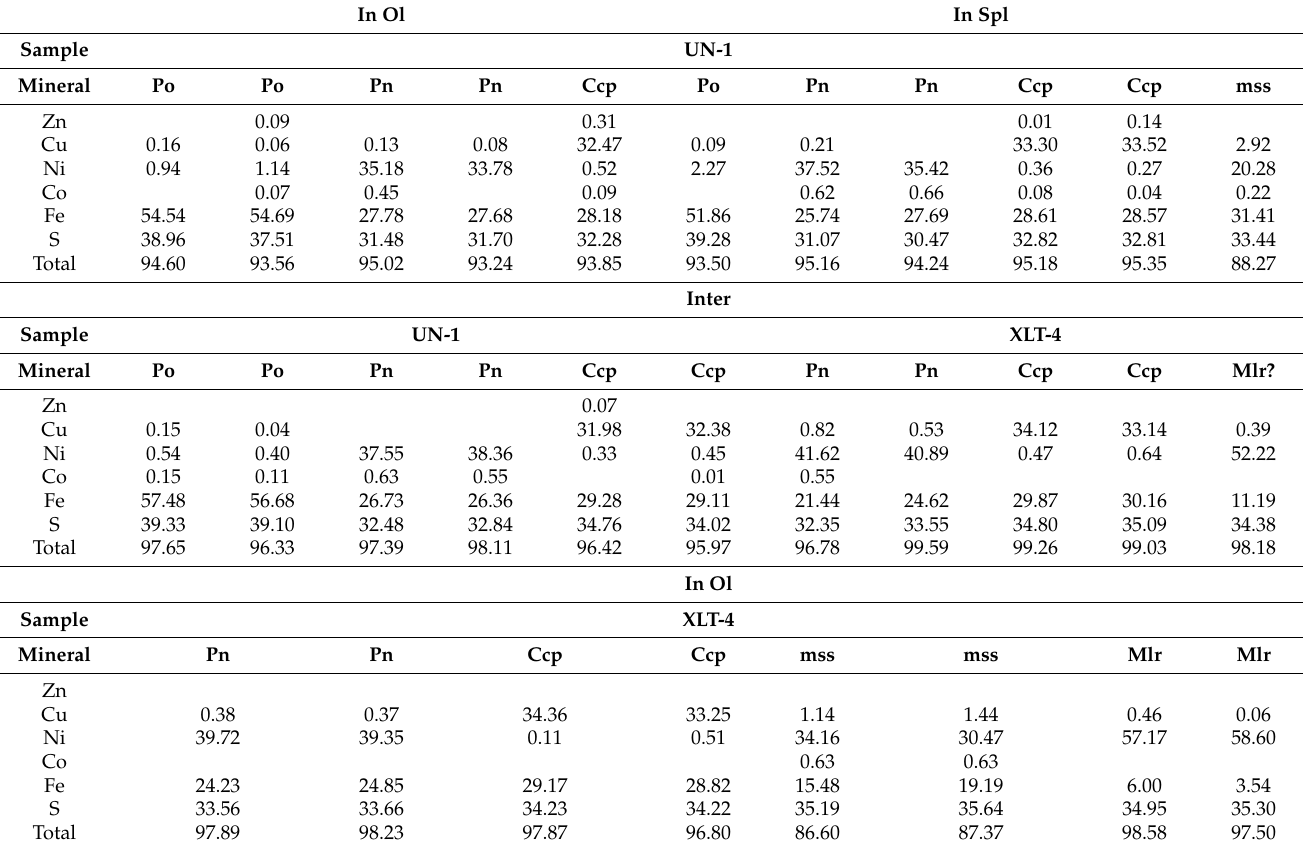
Table 2. Representative SEM analyses of sulfides in Cpx-rich Spl lherzolites from East Antarctica (wt%). In